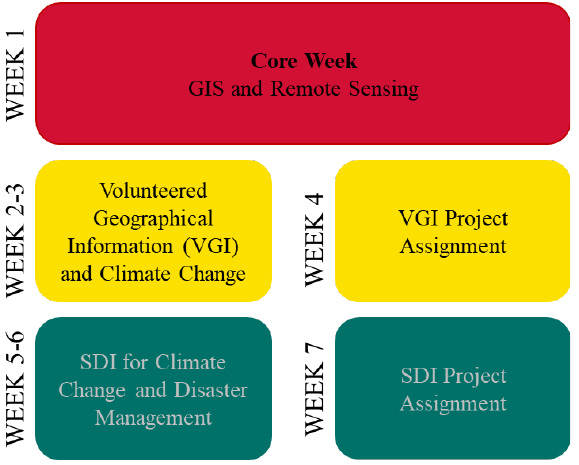
Figure 3. Core week structure and